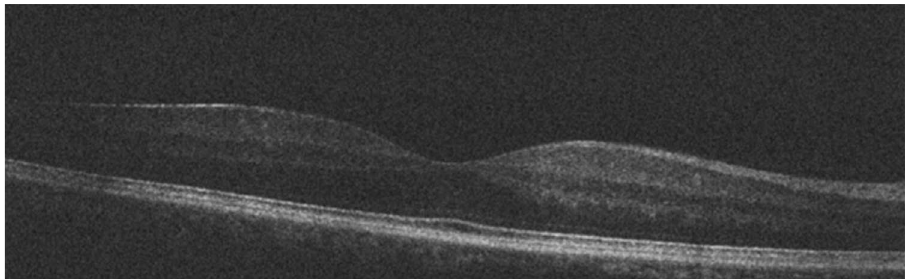
Figure 2. Fellow eye OCT image of a case with off-macular detachment.